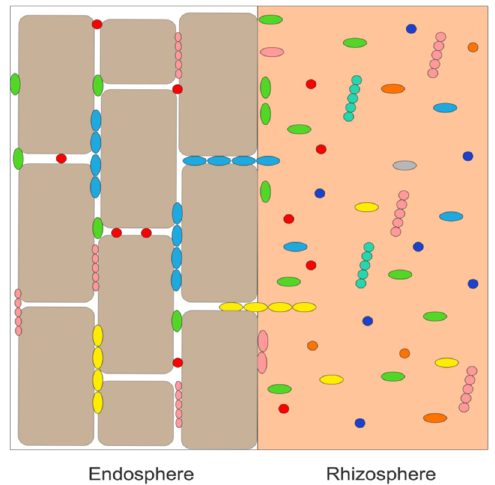
Figure 1. Schematic representation of various rhizosphere bacteria (as shown by different colored shapes) being taken up from the rhizosphere and localized intercellularly in the plant root en ‐